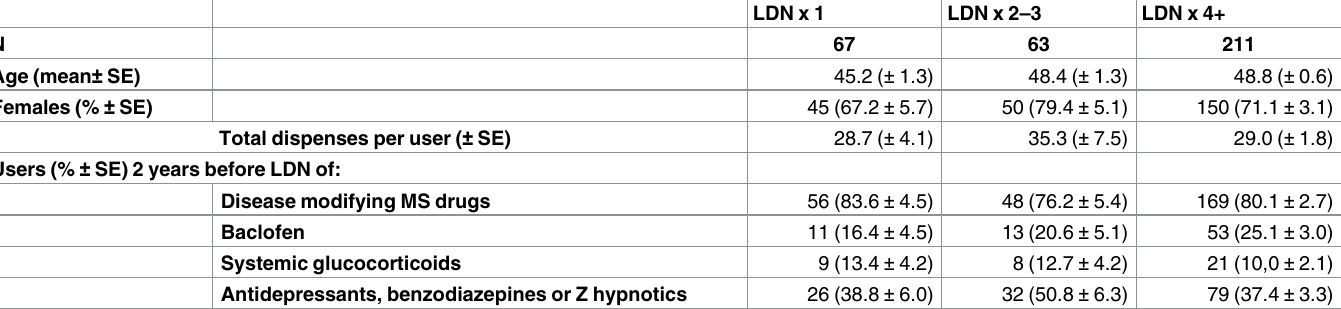
Table 1. Baseline data of the three cohorts with standard error (SE). Total dispensesper user includesoutcome and non-outcome drugs 2 years before